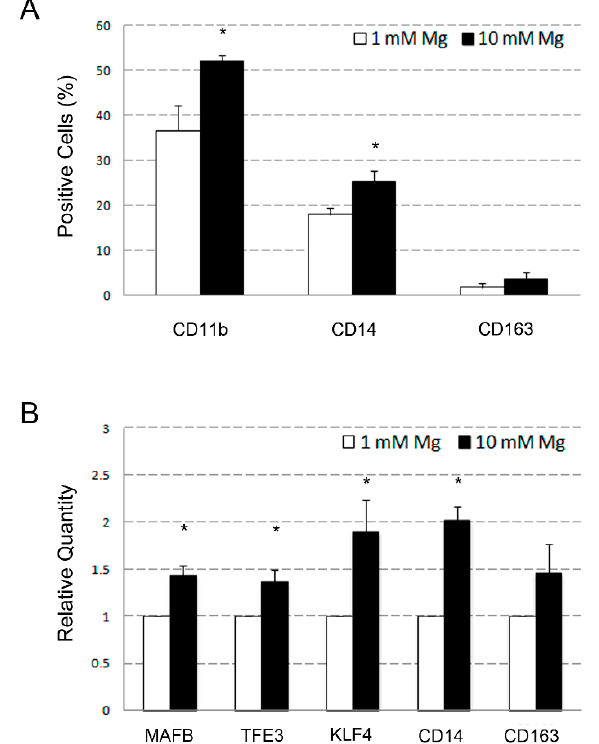
Figure 3. Effects of supra-physiological Mg concentrations determined on U937 cell-derived monocytes. U937 cells were differentiated to monocytes by stimulation with VD3 for five days, and contextually exposed to 1 and 10 mM Mg concentrations. Cell samples were then subjected to flow cytometry and QRT-PCR analysis of typical markers related to the monocyte–macrophage differentiation lineage. Panel A shows the results of flow cytometry represented as a histogram, indicating the analyzed surface antigen on the x -axis and the percentage of positive cells on the y -axis. Panel B shows the results of QRT-PCR, indicating analyzed genes on the x -axis and the relative quantity of mRNA variations on the y -axis. Data are represented as means ± SEM values of a triplicate experiment. Asterisks indicate statistically significant results. p < 0.05.